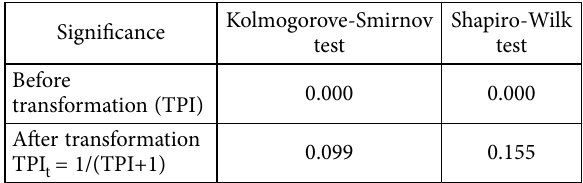
Table 4. Normality test results before and after normal transformation